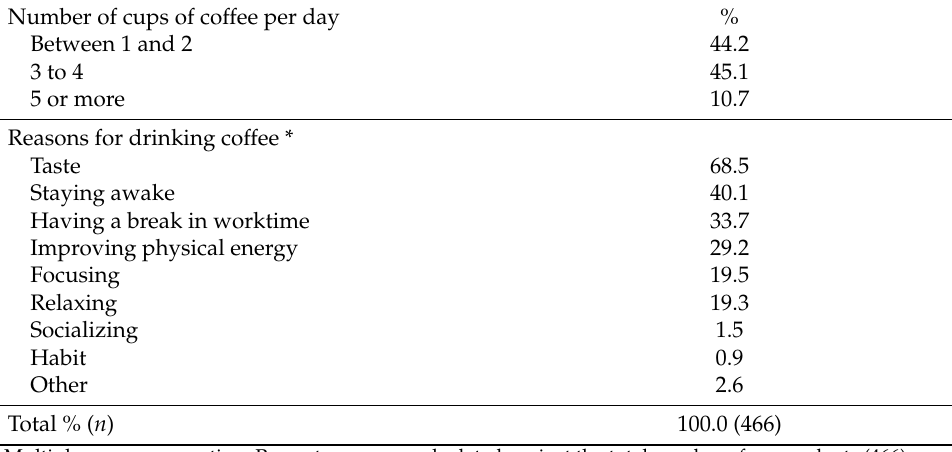
Table 5. Number of cups of coffee per day and reasons for drinking